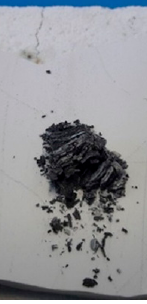
Figure 1. XRD spectra for ( a ) Mg-silicide powders ( b ) as sintered sample ( c ) aged Mg-silicide at 500 ◦ C for 120 h without coating ( d ) aged Mg-silicide at 500 ◦ C for 120 h with coating and ( e ) PDF card of Mg 2 Si 0.4 Sn 0.6 (n. 01-089-4254). Figure 2. Mg-silicide uncoated after aging at 500 °C for 120 h, in air.